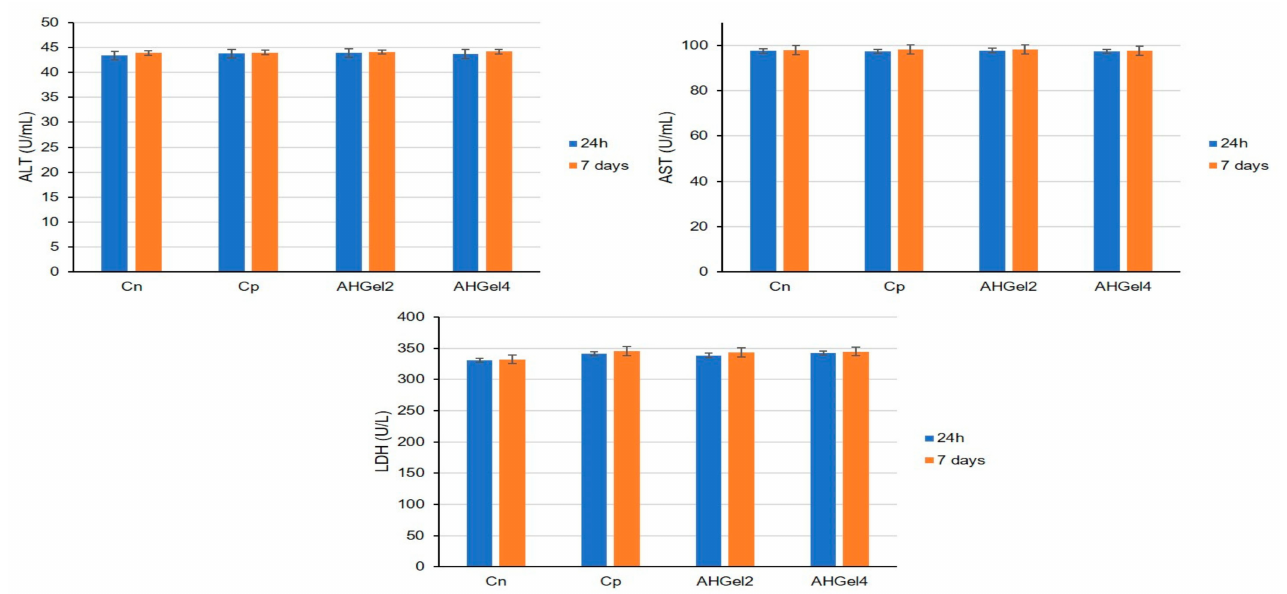
Figure 10. Effects of Amox-loaded hydrogels implantation on ALT, AST and LDH activity. For all data the values are presented as mean ± S.D.